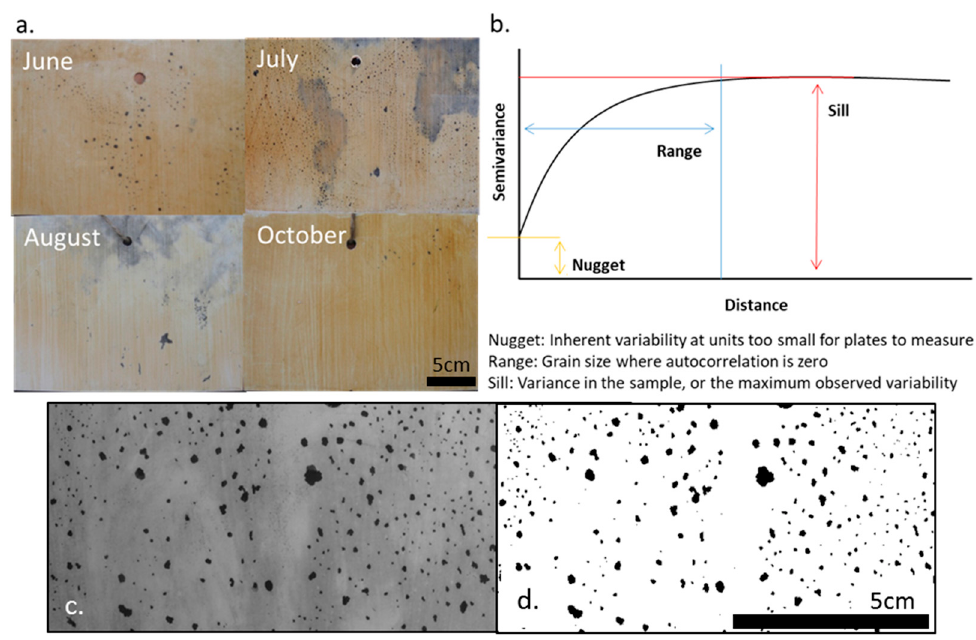
Figure 2. ( a ) Representative IRIS plates at each sampling date. FeS appears as black complexes, either discretely or as aggregated units. ( b ) A model semivariogram and the variables extracted. And, a raw plate showing FeS complexes transformed to ( c ) greyscale and ( d ) black and